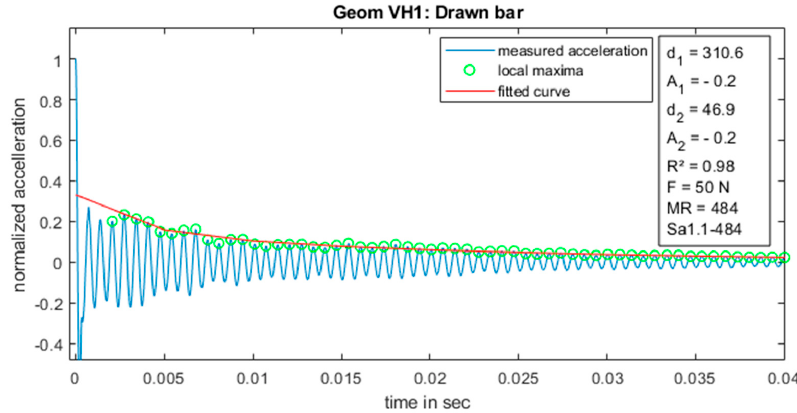
Figure 8. Acceleration data and fitted curve for a drawn bar.